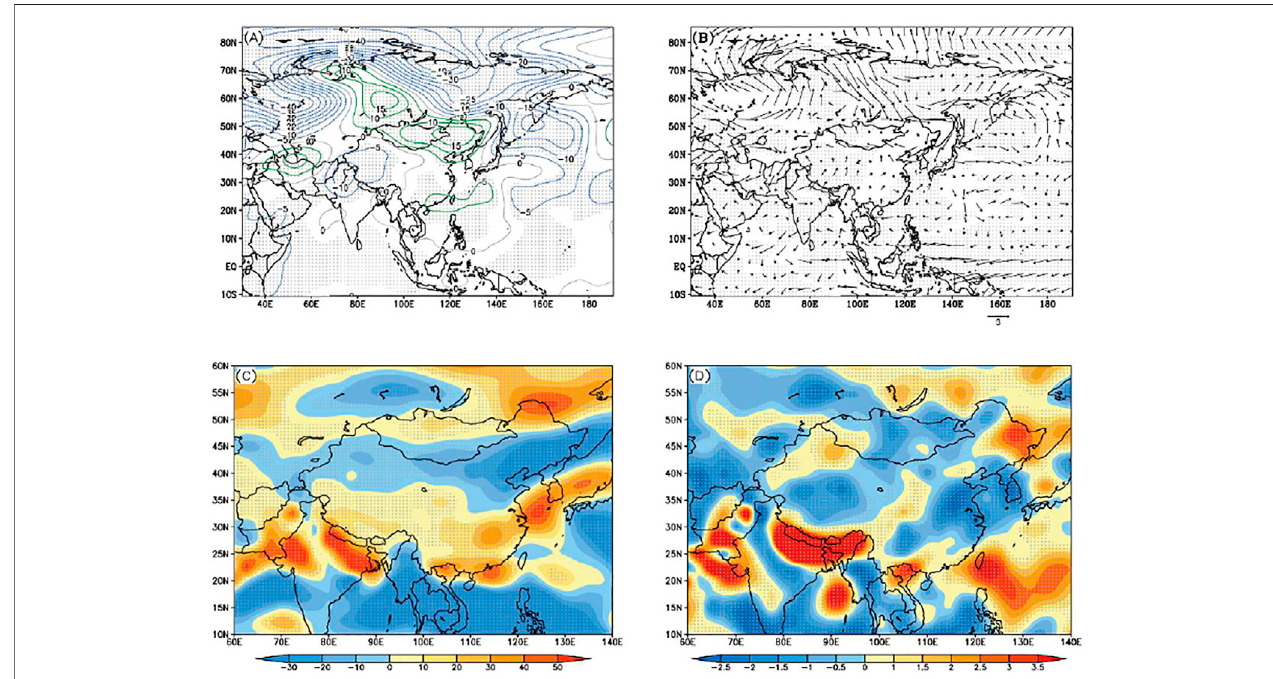
FIGURE 10 | Difference in (A) geopotential height, (B) wind at 500 hPa, (C) vertically integrated water vapor fl ux (surface to 300 hPa), and (D) vertically integrated watervapor fl uxdivergence(surfaceto300 hPa)duringAugustintheyearswiththehighestextremeprecipitationconcentrationperiod.Graydotsindicatesigni fi canceat the 0.05 level (two-tailed Student ’ s